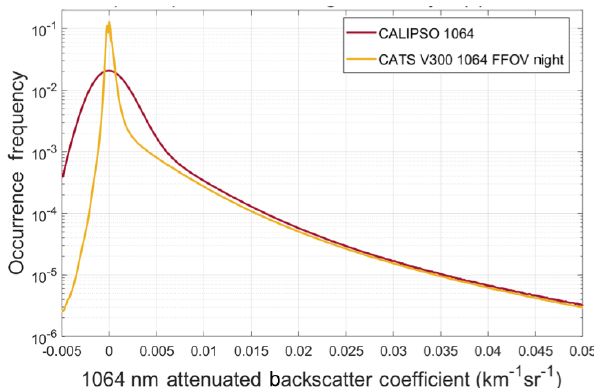
Figure 10. Relative frequency distributions of 1064nm attenuated backscatter coefficients measured by CALIOP (V4.10) and CATS (V3-00) from April through September 2016 at night with temper- atures less than − 40 ◦